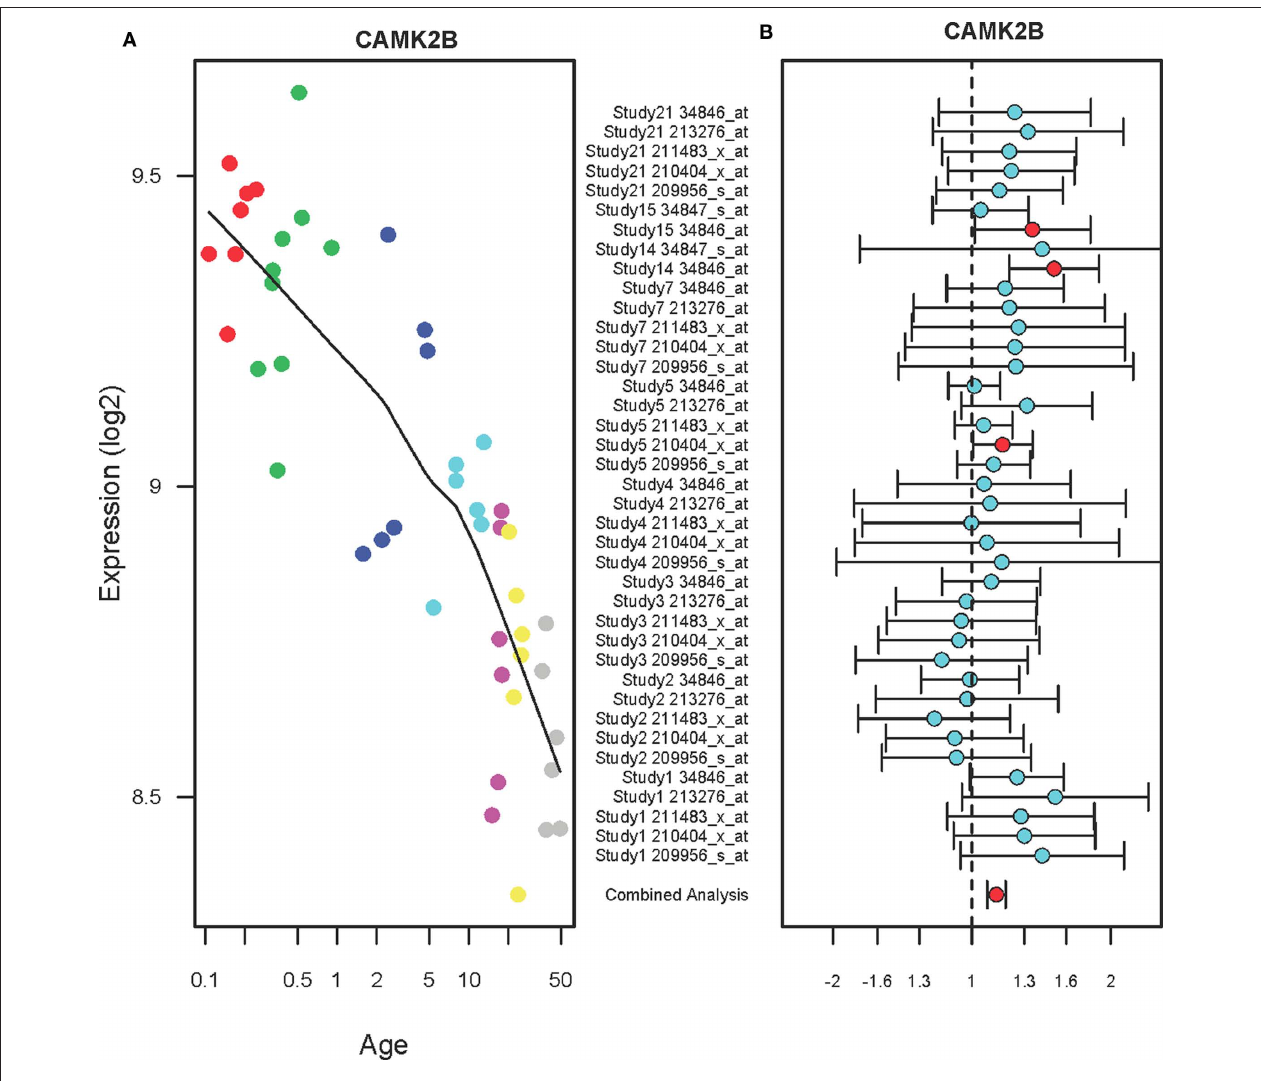
and 95% confidence intervals shows consistent up-regulation of CAMK2B in the PFC of suicide victims as compared to the non-suicide controls across nine microarray studies. A combined analysis shown on the bottom represents the weighted fold change and 95% confidence intervals. Individual microarray probes for CAMK2B across multiple studies are shown on the left (Study ID and Affymetrix probe ID). Red circle: adjusted p < 0.05, Cyan circle: adjusted p